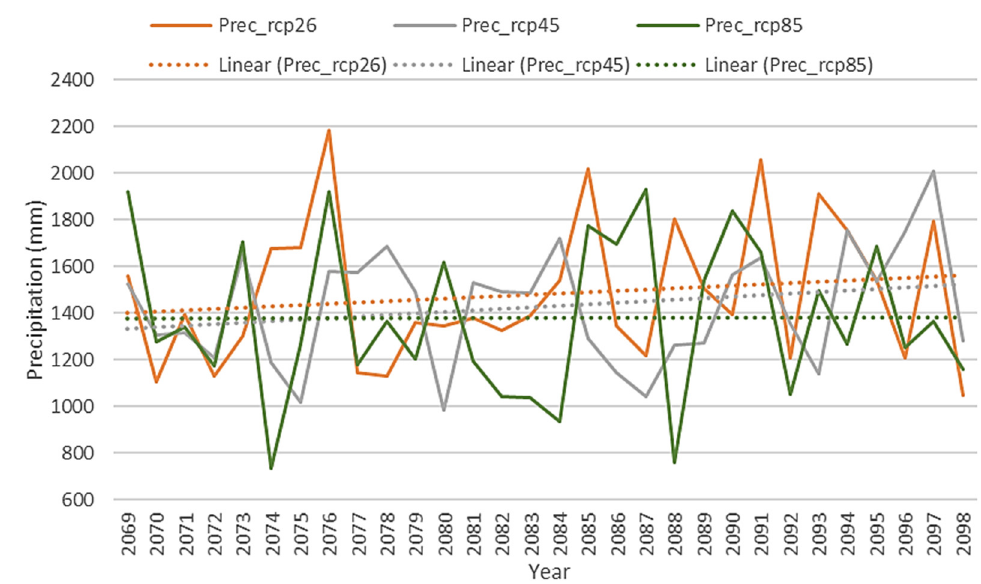
Figure 5. Annual precipitation values for the period of 2061–2098 for the 3 climate scenarios .